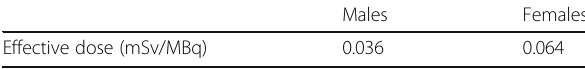
Table 6 Effective dose for 18 F-TFB in healthy participants